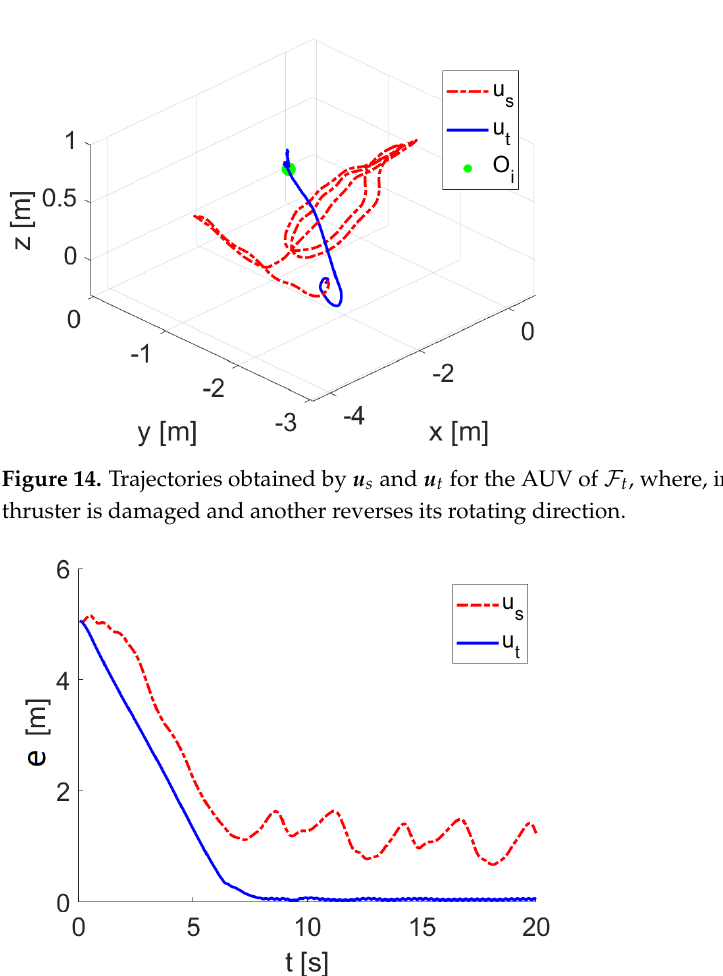
Figure 15. Errors of position regulation obtained by u s and u t for the AUV of F t , where, in the target dynamics, one thruster is damaged and another reverses its rotating